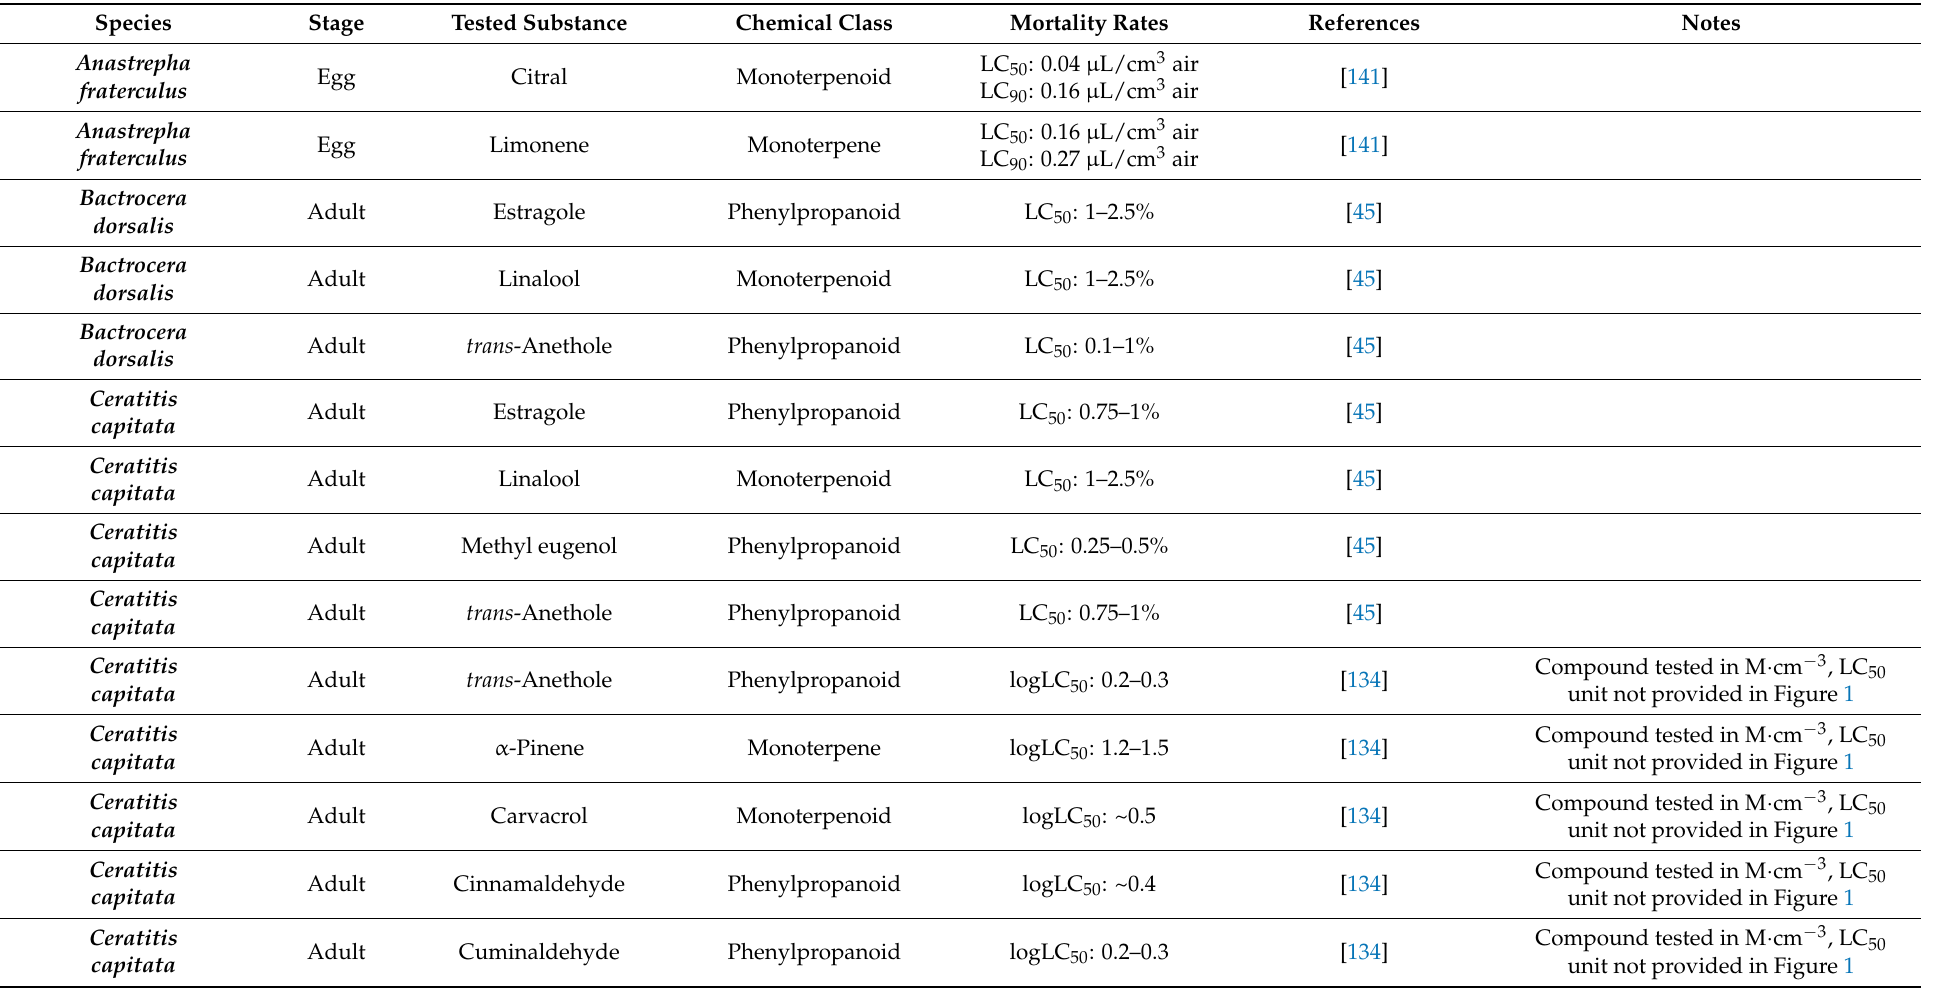
Table 3. Terpenoids and phenylpropanoids were examined for fumigant action against immature and adult stages of Tephritidae